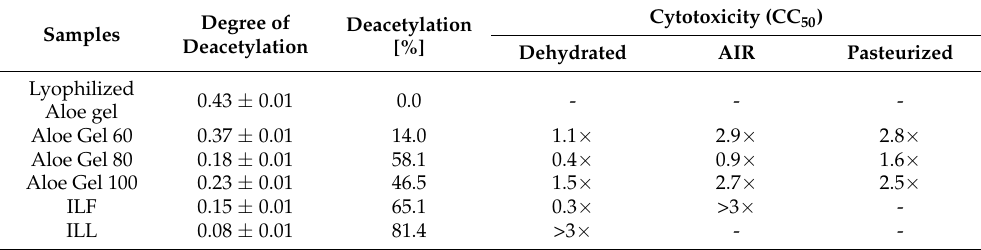
Table 1. Degree of acetylation of acemannan from AIRs dehydrated at different temperatures compared to freshly lyophilized Aloe gel. Mean ± SD. Comparison of median cytotoxic concentration on HT-29 cells according the sample